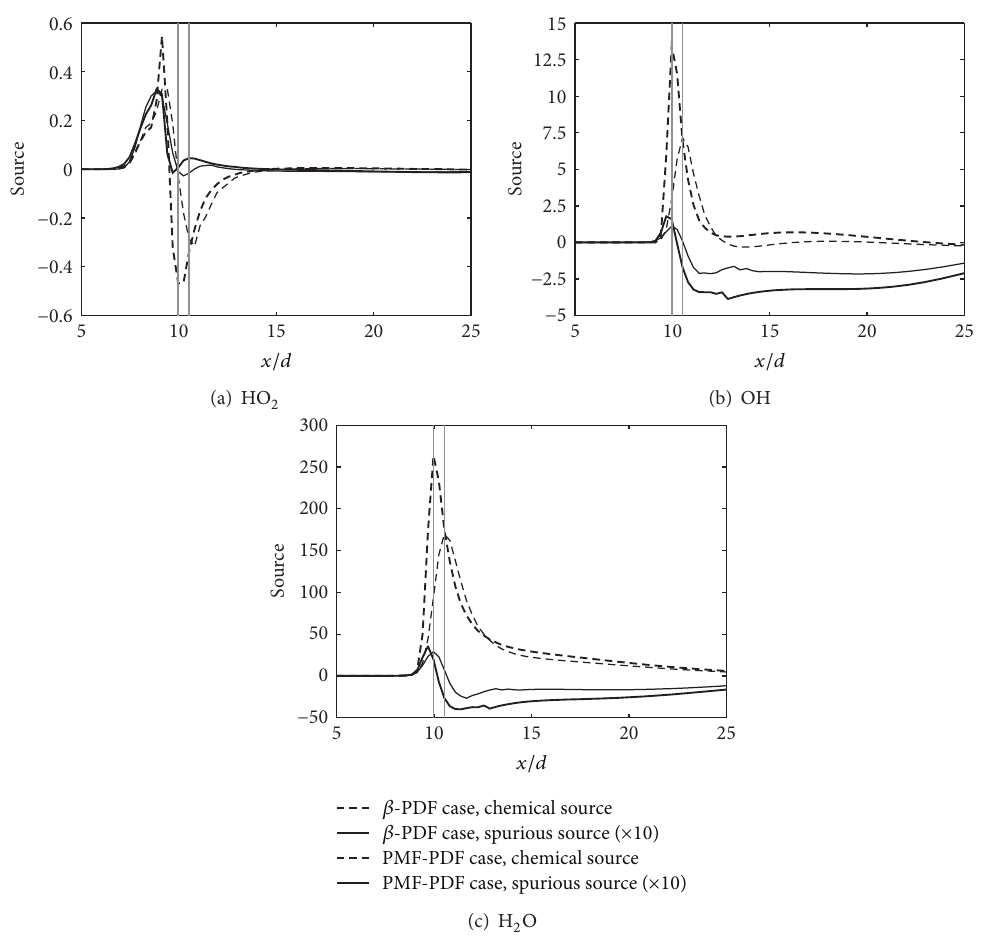
Figure 9: Axial profiles of the chemical and spurious sources at 𝑦/𝑑 = 1 . 47 (radial locations of stabilisation) for 𝑇 𝑐 = 1045 K: (a) HO O. All spurious sources are multiplied by 10 and the units are s − 1 . The vertical grey lines indicate the axial locations of the OH, and (c) H 2 stabilisation heights: thin, 𝛽 -PDF; thick,